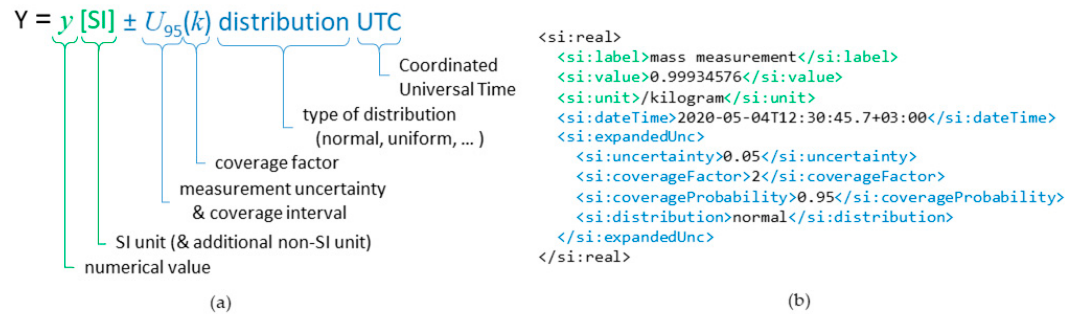
Figure 1. The Digital SI (D-SI) universal data model ( a ) and an example data sample in the XML format ( b ). Minimum requisite information is shown in green and the timestamp and expanded measurement uncertainty in blue.